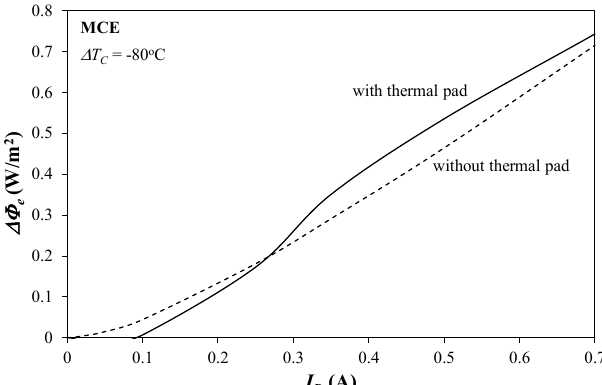
Figure 11. Measured dependences of the surface power density change ∆ Φ e of the diodes MCE on forward